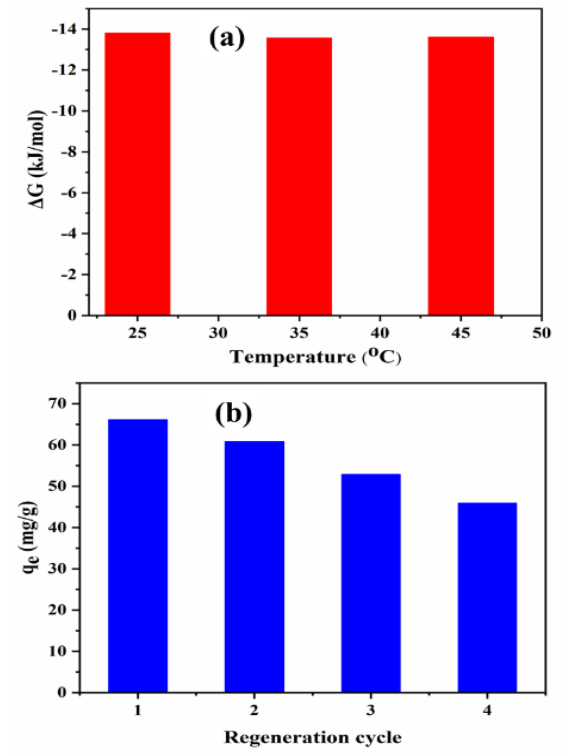
Figure 7. ( a ) Thermodynamic coefficients and ( b ) Consecutive regeneration and reusing of SBAC- MgAlFe for phenol uptake.